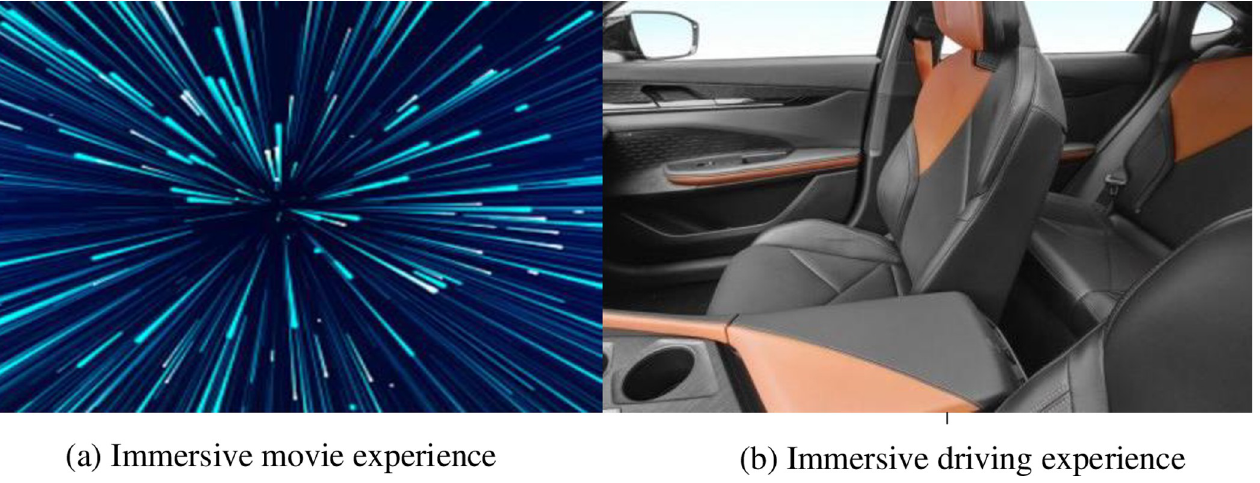
Fig 5. Immersive